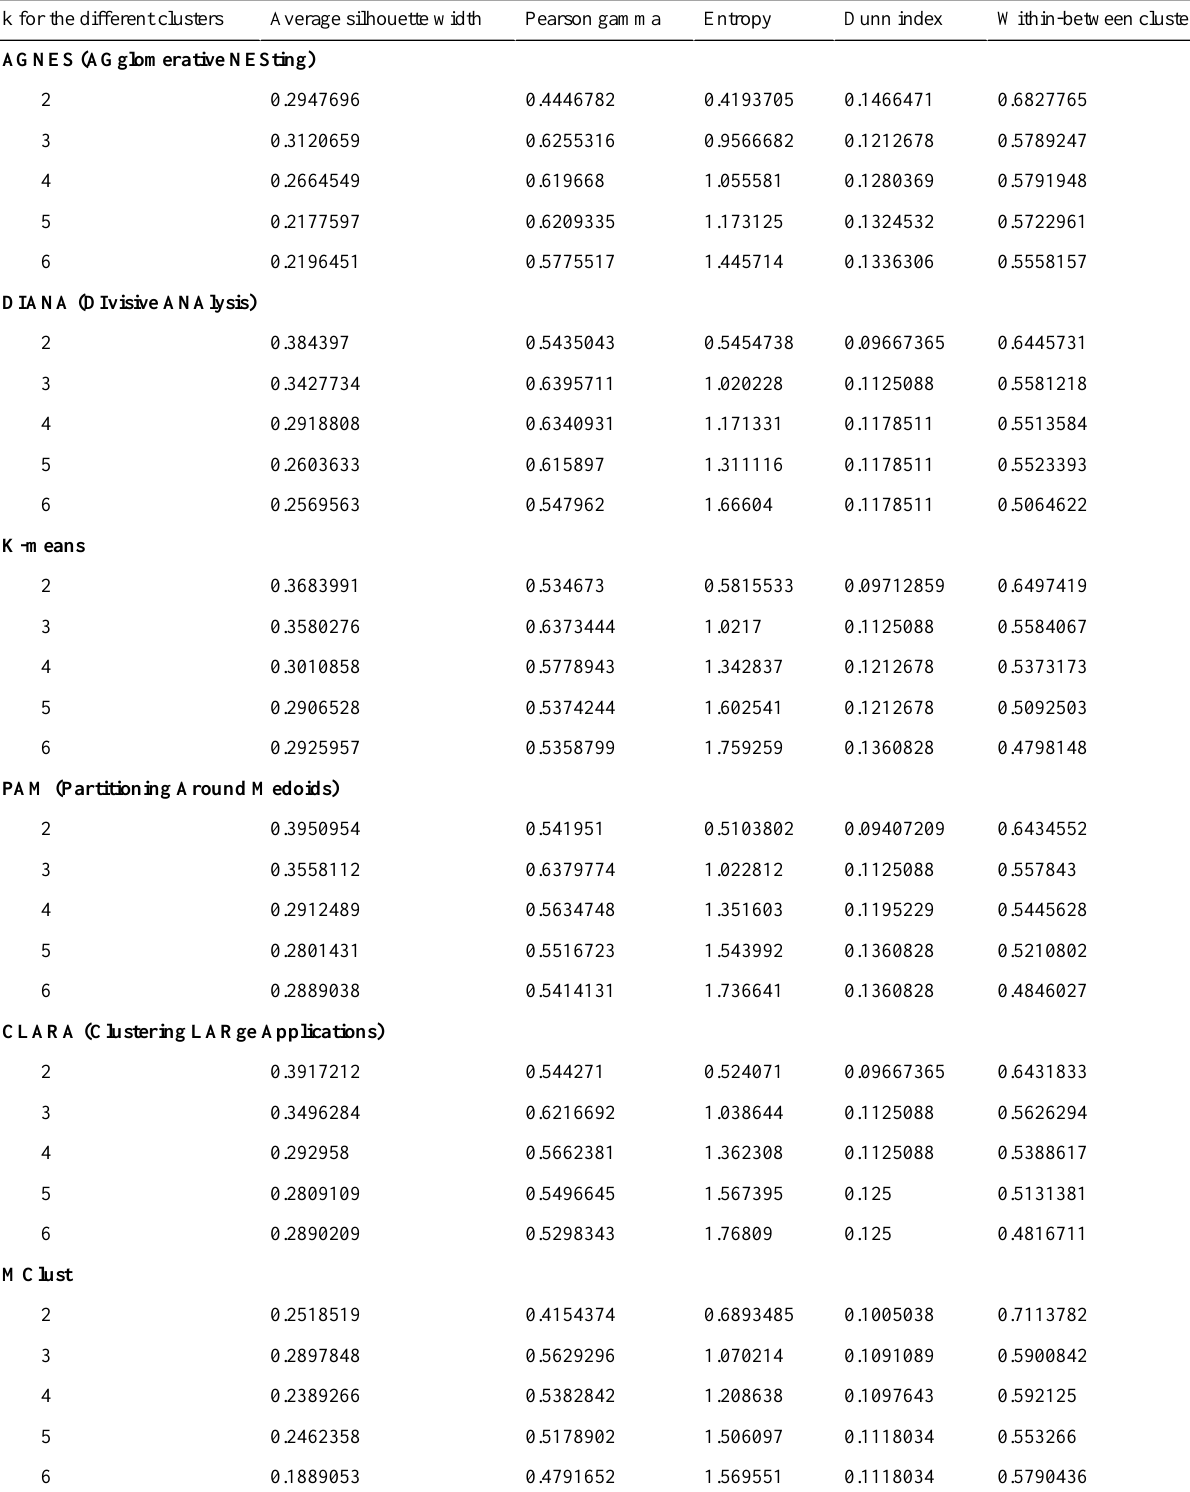
Table 1. Internal validation of the proposed techniques for different number of